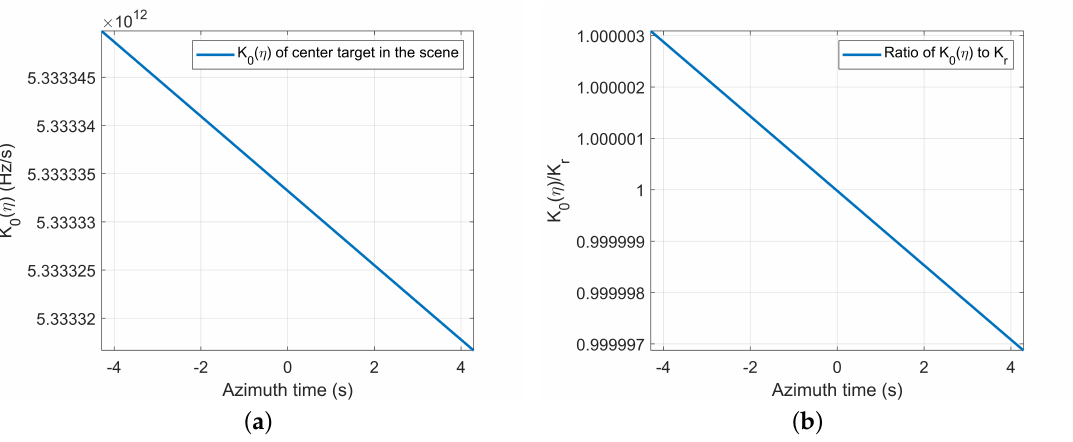
Figure 11. ( a ) The azimuth-time-varying FM rate K 0 ( η ) of center target in GF-3 experiment. ( b ) The ratio of K 0 ( η ) to K r